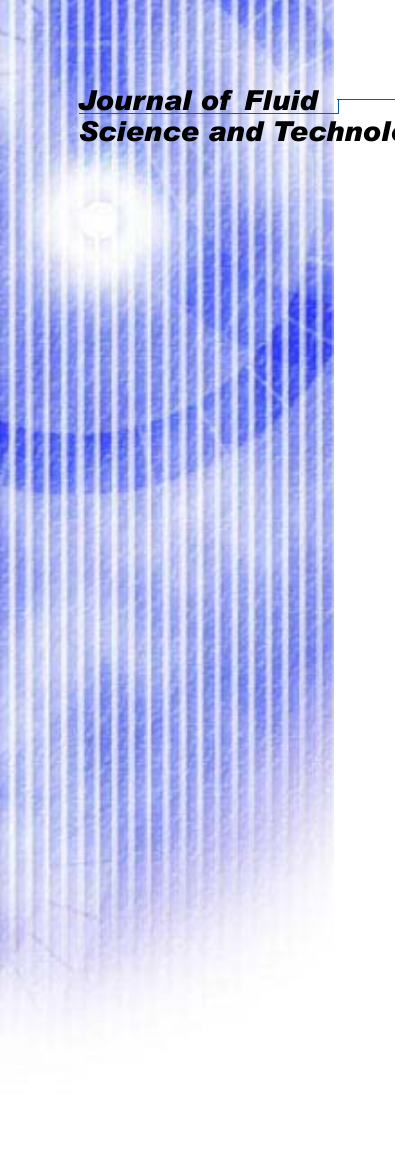
Fig. 6 Vorticity contours obtained from the wakes of heaving airfoils with St =